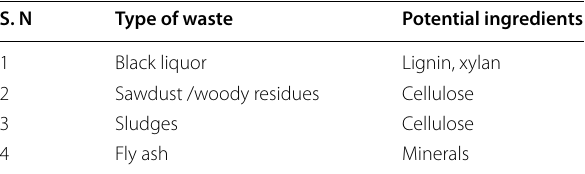
Table 7 Potential ingredients available from pulp and paper mill waste